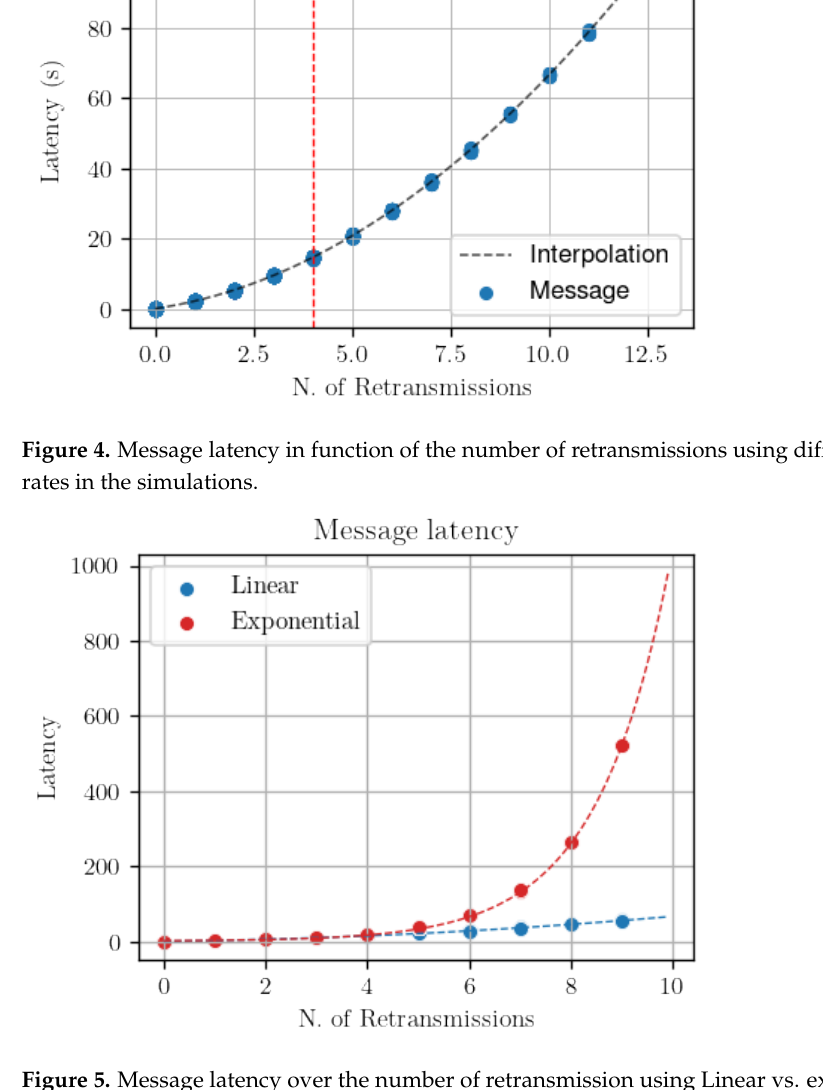
Figure 5. Message latency over the number of retransmission using Linear vs. exponential retrans- mission timeout